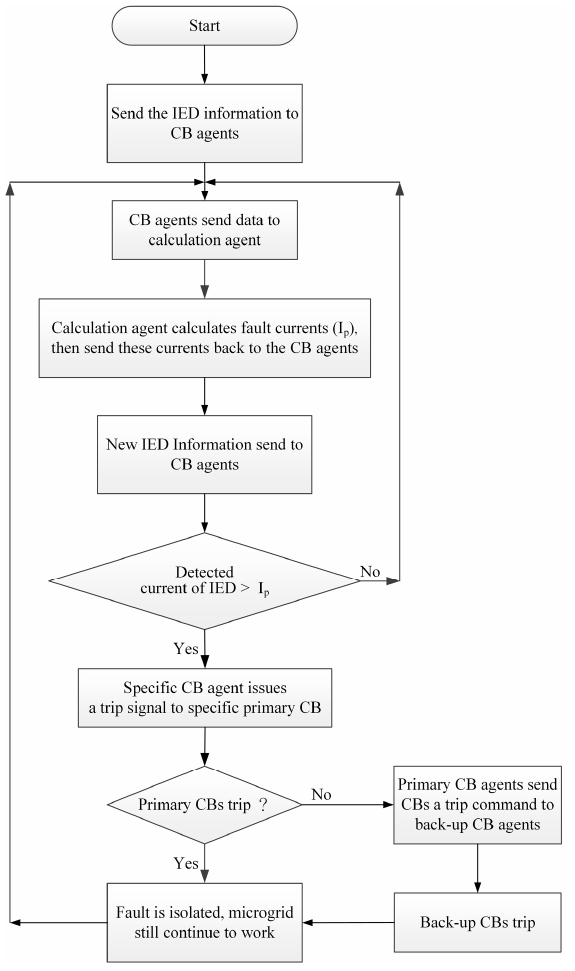
Figure 4. Flowchart for implementation of proposed fault protection for MAS-based microgrid control.